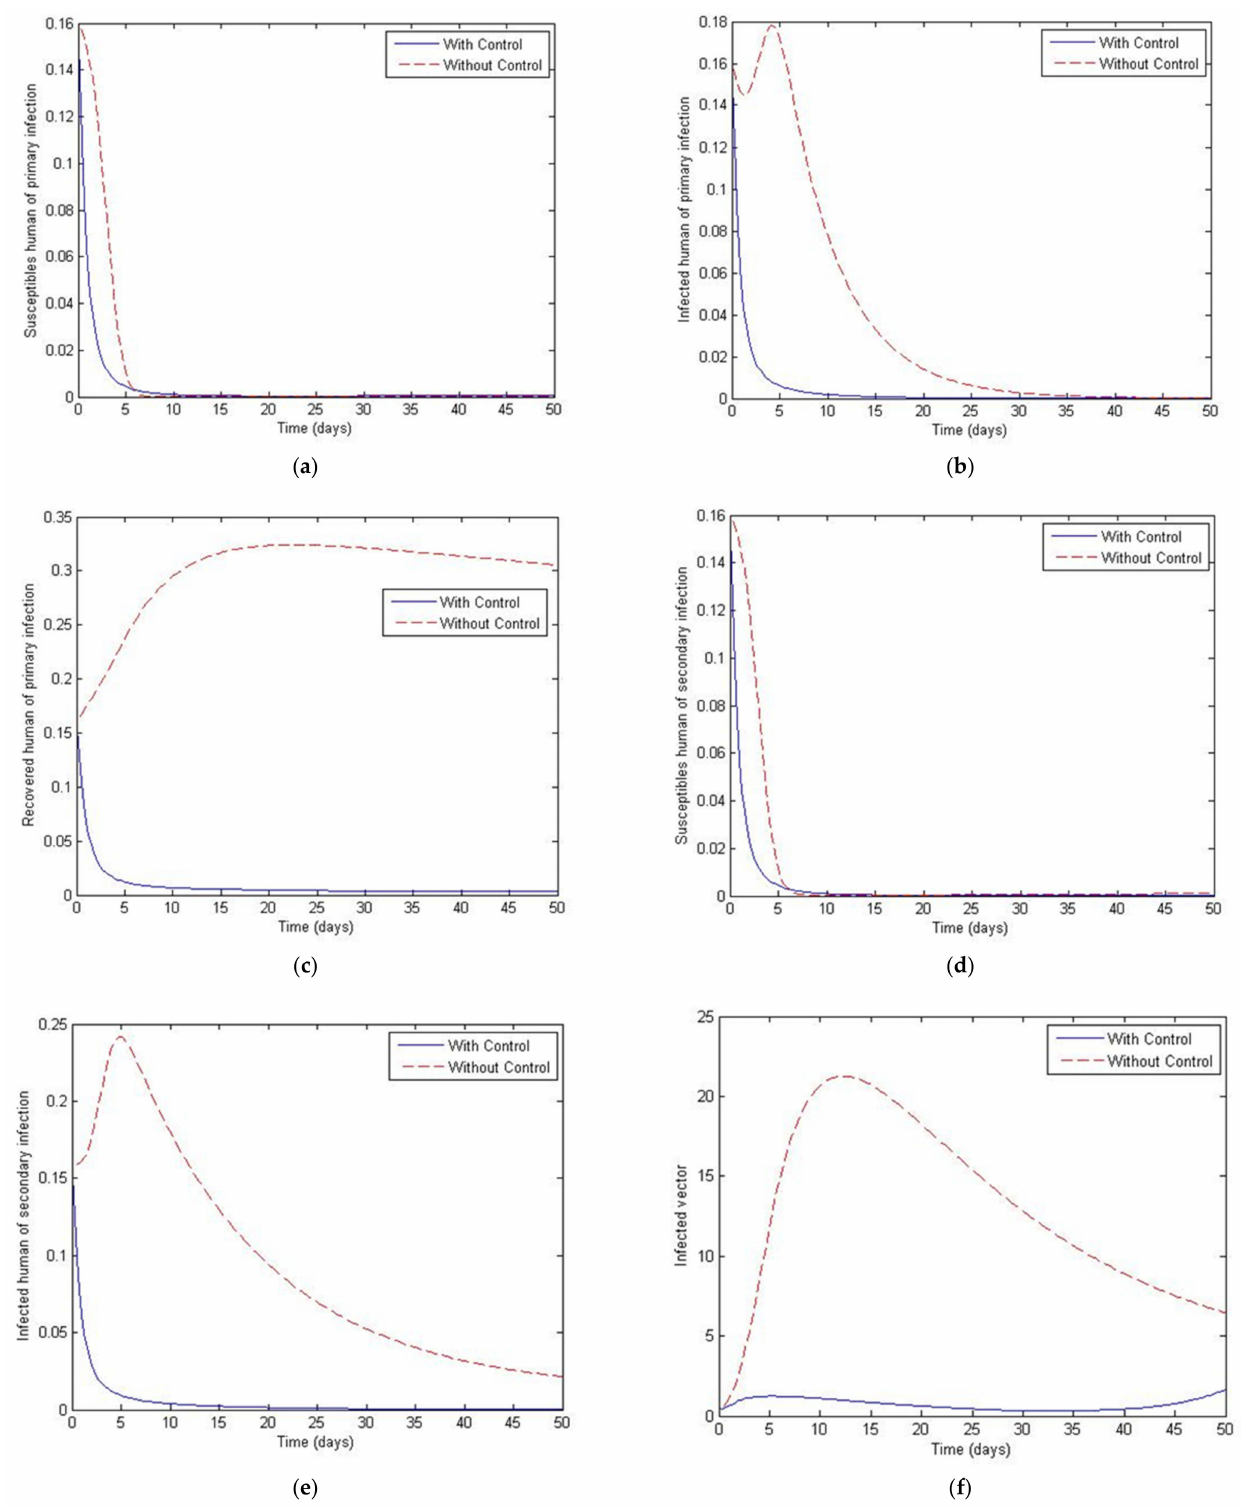
Figure 11. Simulation results of system of Equations (38)–(43) with and without controls of S HP , I HP , R HP , S HS , I HS and I V for X 1 = 100, X 2 = 100. ( a ) Susceptibles of primary infection ( b ) Infected population with primary infection ( c ) Recovered human of primary infection ( d ) Susceptibles of secondary infection ( e ) Infected human of secondary infection ( f ) Infected